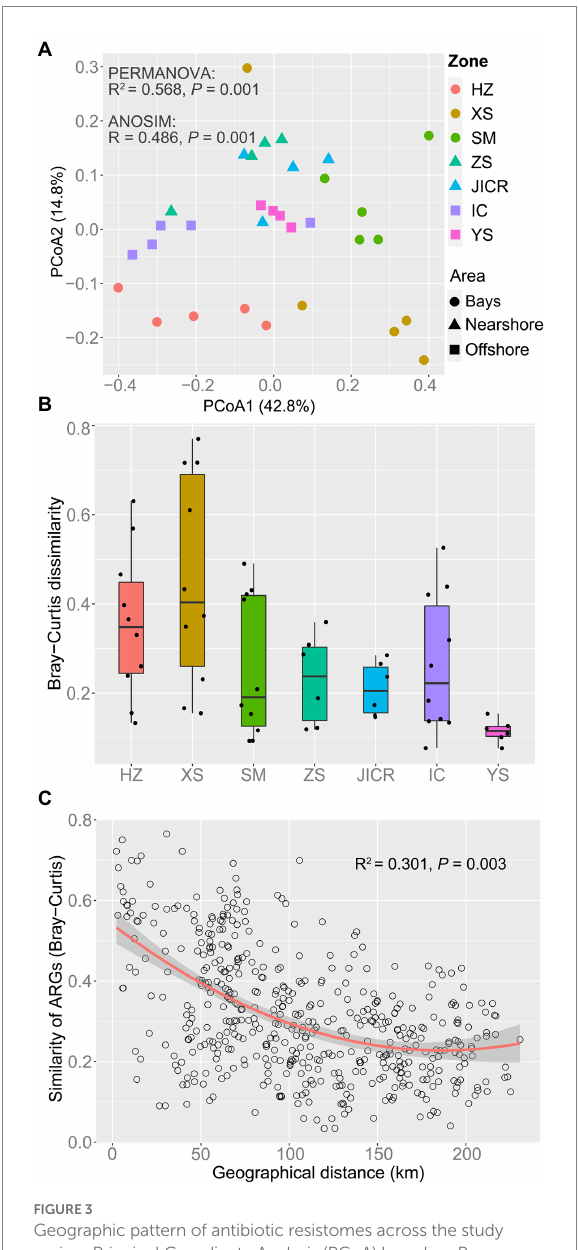
FIGURE 3 Geographic pattern of antibiotic resistomes across the study region. Principal Coordinate Analysis (PCoA) based on Bray– Curtis dissimilarity visualizing compositional variation of antibiotic resistomes (A) . Permutational Multivariate Analysis of Variance (PERMANOVA) and Analysis of Similarity (ANOSIM) were used to test the significance of variation in antibiotic resistomes across zones. Box plots showing the heterogeneity of antibiotic resistomes within each zone (B) . Refer to the Figure 2 for the features of the boxes. Distance-decay relationship between Bray–Curtis similarity of antibiotic resistomes and geographic distance between sampling stations (C) . The red line represents a binomial fit with adjusted R 2 . The shaded area represents 95% confidence